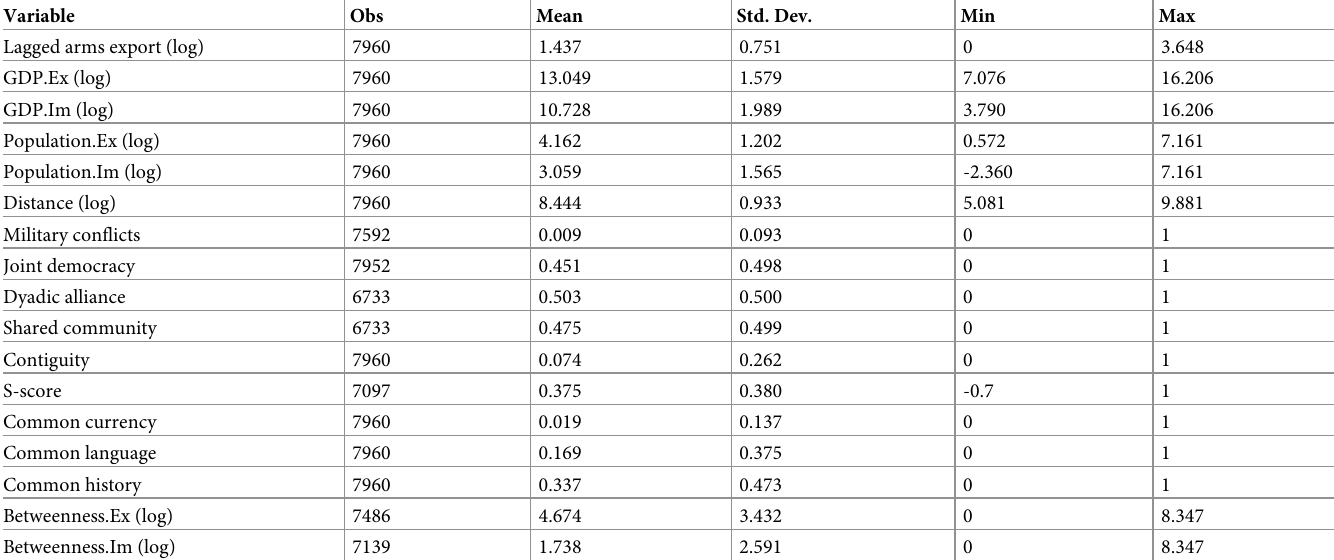
Table 4. Descriptive